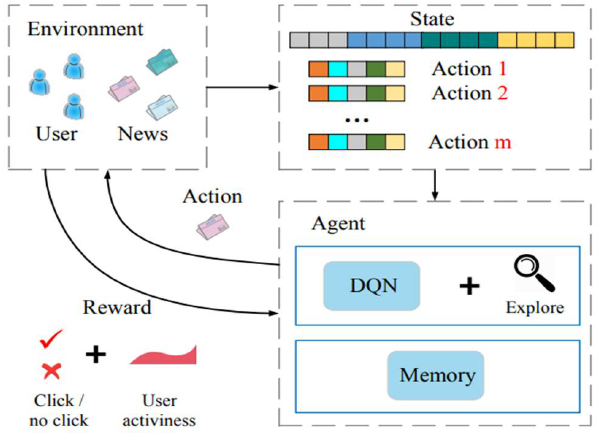
Figure 3. DRN system.